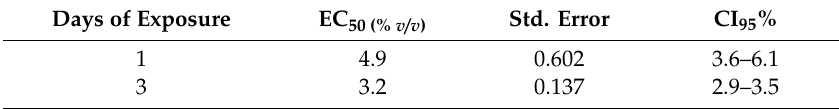
Table 1. EC 50 (% w / v ) values of cheese whey against M. javanica calculated after immersion of J2s in test solutions for 1 and 3